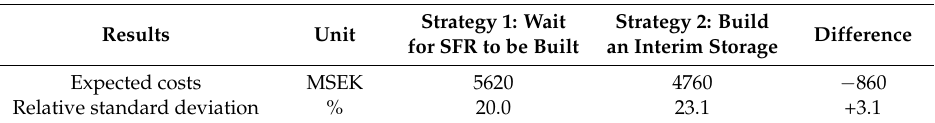
Table 3. Main results from the